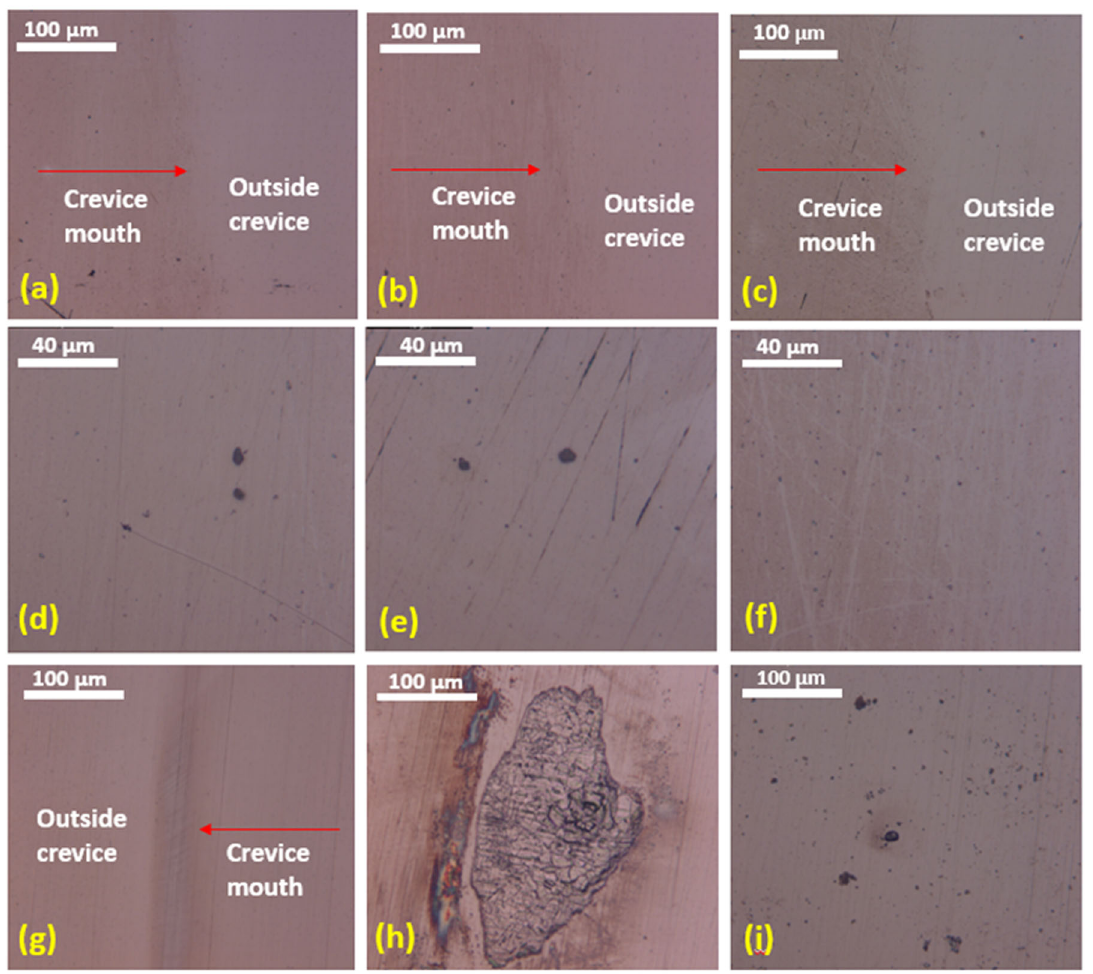
Fig. 2 Optical Microscopy images of morphology of crevice corrosion observed on SS( + ISG) and SS( + PTFE) after 12 months of exposure in silica-saturated 0.6 M NaCl. a – c Images acquired at the crevice mouth with arrows demarcating the crevice mouth. d – f Images acquired in the SS( + ISG) crevice interior. g – i SS( +